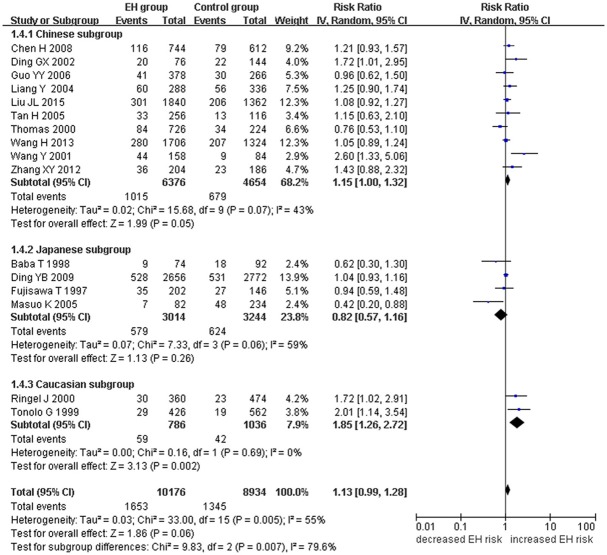
Forest plot of EH associated with ADRB3 gene Trp64Arg polymorphism under an allelic genetic model (distribution of Arg allelic frequency of ADRB3 gene Trp64Arg polymorphism).